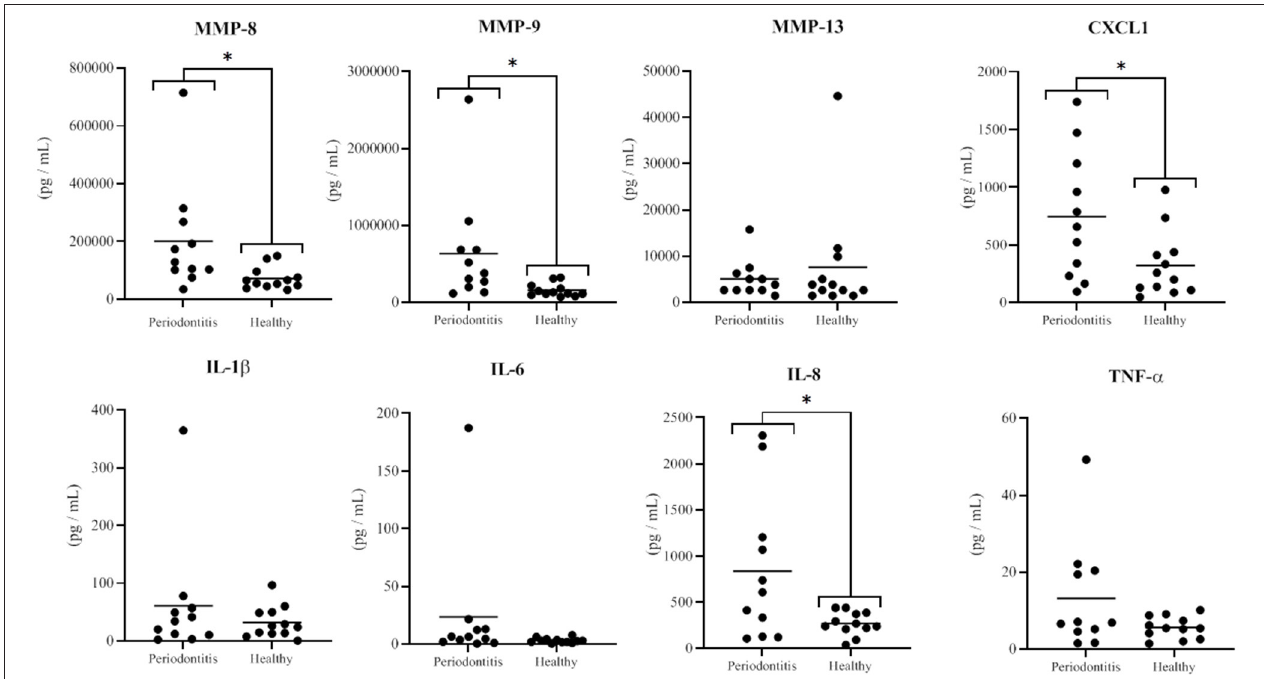
FIGURE 1 | Concentrations of MMPs and cytokines in saliva samples from the periodontitis and healthy subjects. The horizontal black lines represent the mean values. The differences between the mean salivary levels of the two groups were considered significant at p < 0.05 (*).